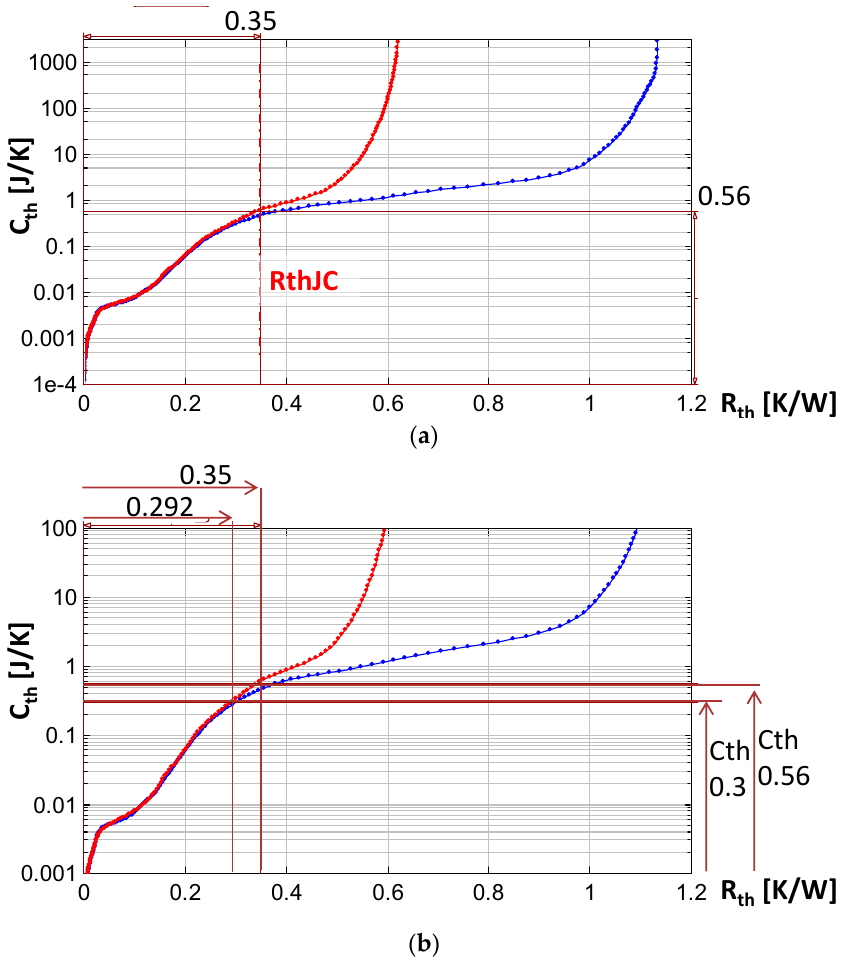
Figure 18. Dual interface measurement of HUF75639G3 structure functions. ( a ) R thJC junction to case thermal resistance determined with ε = 0.05. ( b )Enlarged detail of a R th@Cth -style thermal parameter read-out at C th = 0.36 J/K. Table 2. Measured R thJC values of HUF75639G3 samples, TO247 case, two-point method. Fixture